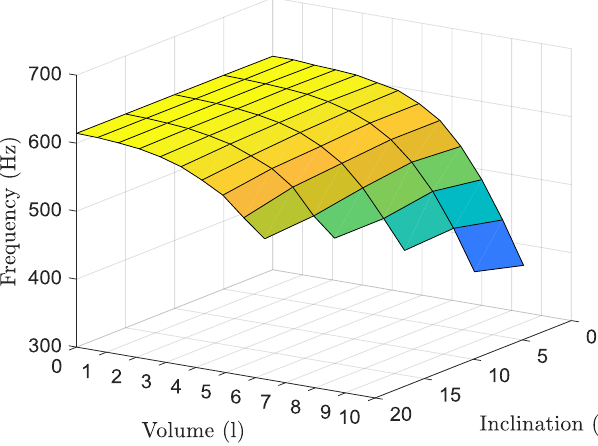
Figure 16. The effect of tank inclination in the measurement.